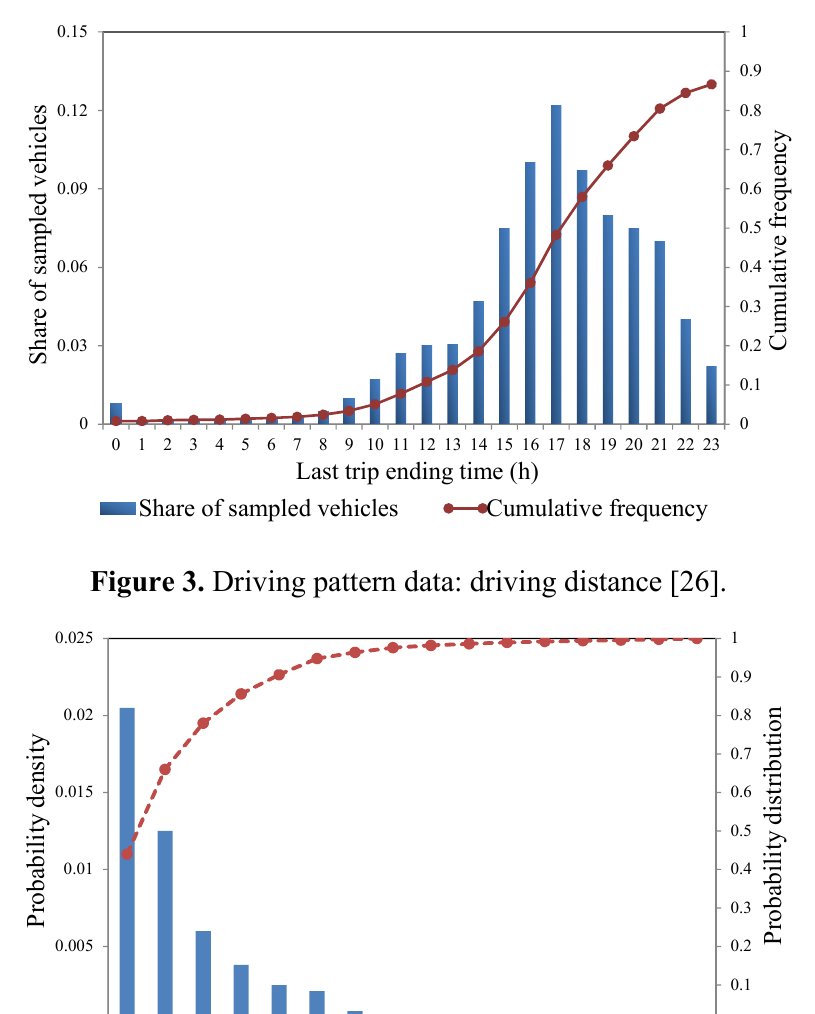
Figure 2. Driving pattern data: trip length [26].